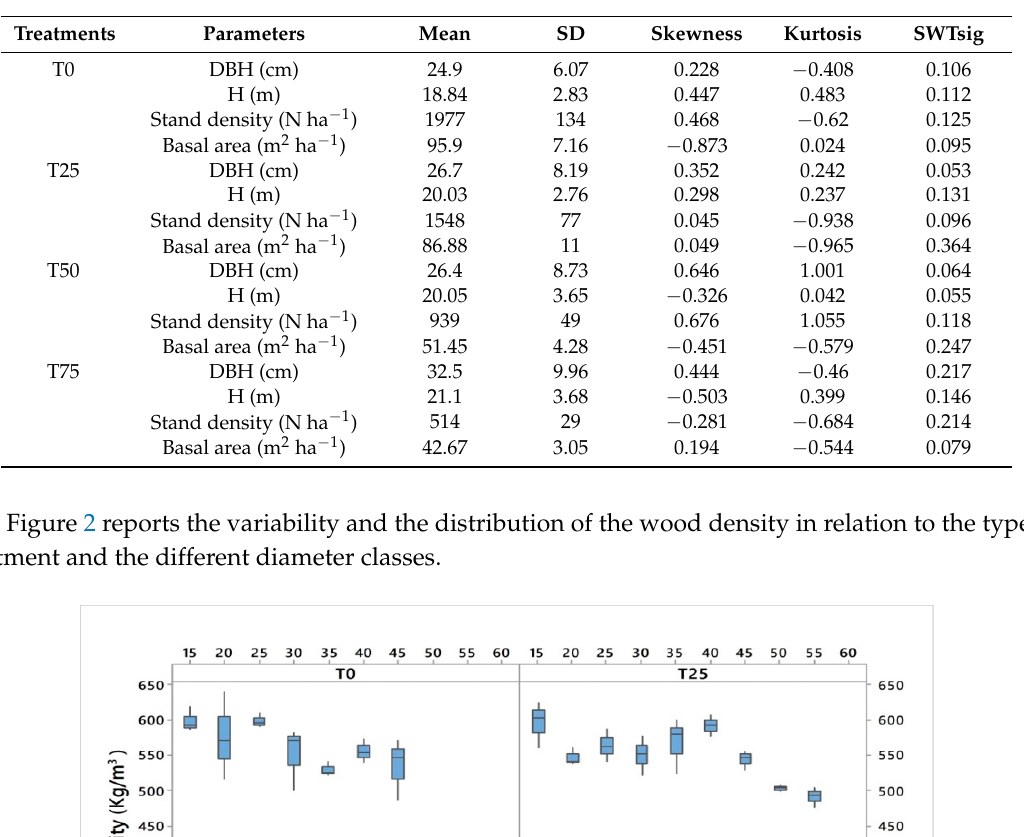
Table 2. Tree wood density, stress wave time, and mechanical properties for the sampled trees among the different treatments considered (SD: standard deviation; MOEd: dynamic modulus of elasticity). Means in the same column followed by the same letter are not statistically different at p ≤ 0.05 (Tukey test). Treatments